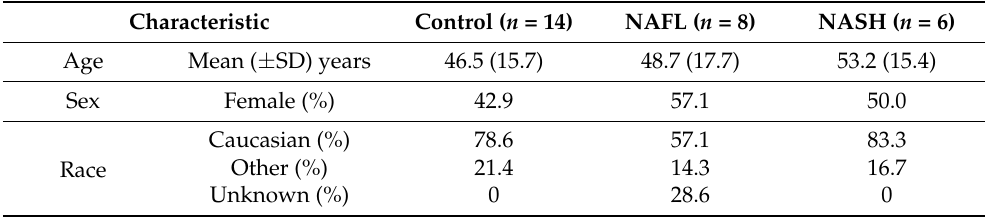
Figure 1. Study workflow. Plasma samples from patients with non-alcoholic fatty liver disease and matched healthy controls were purchased from Discovery Life Sciences (DLS). Samples were aliquoted for miRNA quantitation directly from plasma and from EVs following their isolation by qEV size exclusion chromatography (SEC) and immunoprecipitation (IP). EVs isolated by qEV were characterised by transmission electron microscopy (TEM), nanoparticle tracking analysis (NTA), and protein expression. Figure was created using BioRender.com [https://app.biorender.com/; accessed 17 January 2022]. Table 1. Demographic information for control, non-alcoholic fatty liver (NAFL) and non-alcoholic steatohepatitis (NASH) study populations.